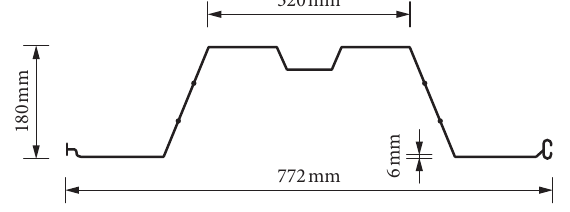
Figure 2: Geometry of FRP composite sheet